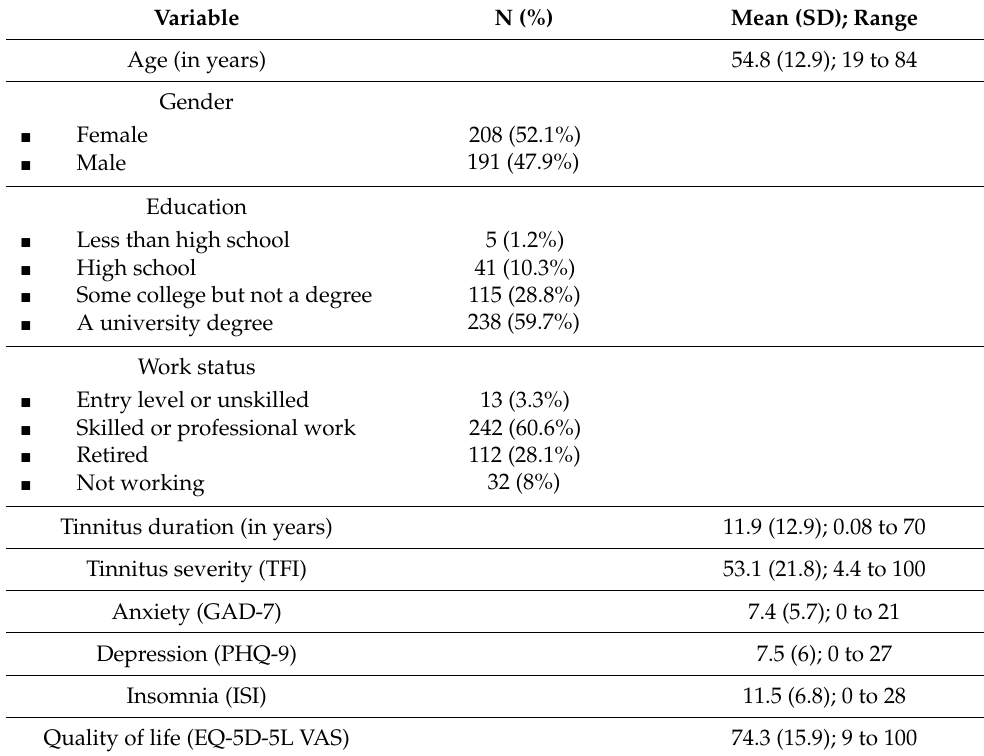
Table 1. Demographic details (n =